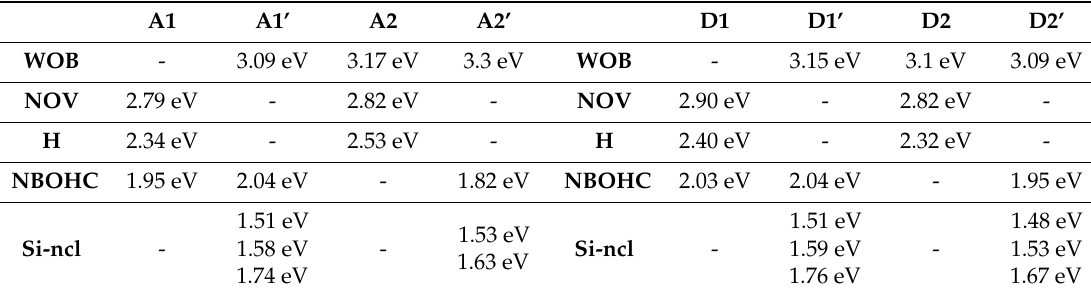
Table 6. PL deconvoluted bands and their proposed defects contributions.